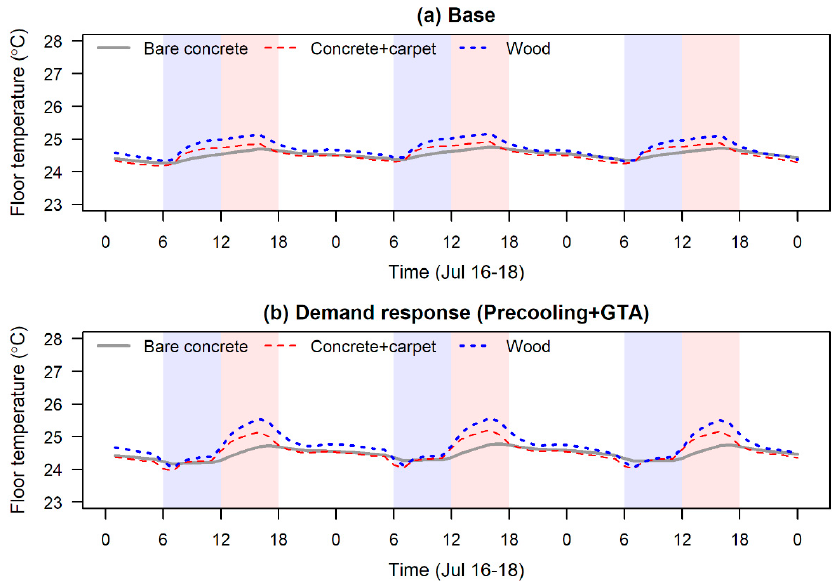
Figure 8. Hourly floor surface temperature of the core zone for three floor configurations: Bare concrete, Concrete + carpet, and Wood under ( a ) Base and ( b ) Precooling + GTA scenarios during 16–18 July in San Francisco, CA. The blue-shaded area indicates the morning or precooling period while the red-shaded area indicates the afternoon or GTA period.